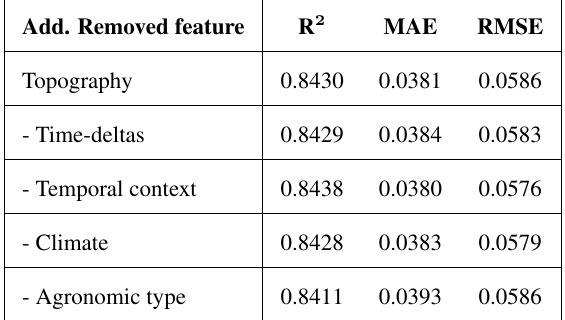
Table 2. Features removed from the SenDVI network